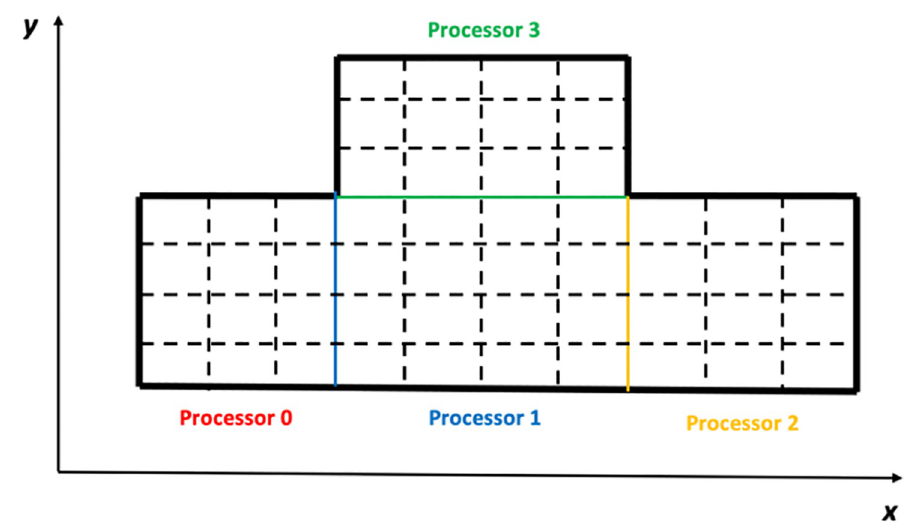
Fig 6. A two-dimensional irregular domain is divided into four regular subdomains. The interfaces of the four subdomains are represented by the three thin and solid lines with three different colors. The blue line is allocated to Processor 1, the yellow line is allocated to Processor 2, and the green line is allocated to Processor 3.